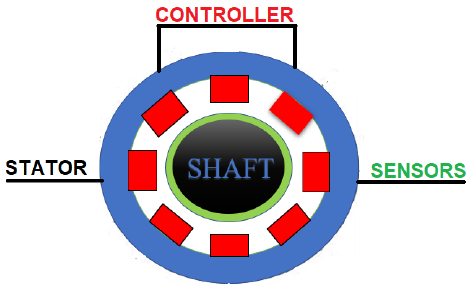
Figure 5. Schematic of the cross-section of the magnetic bearing system.